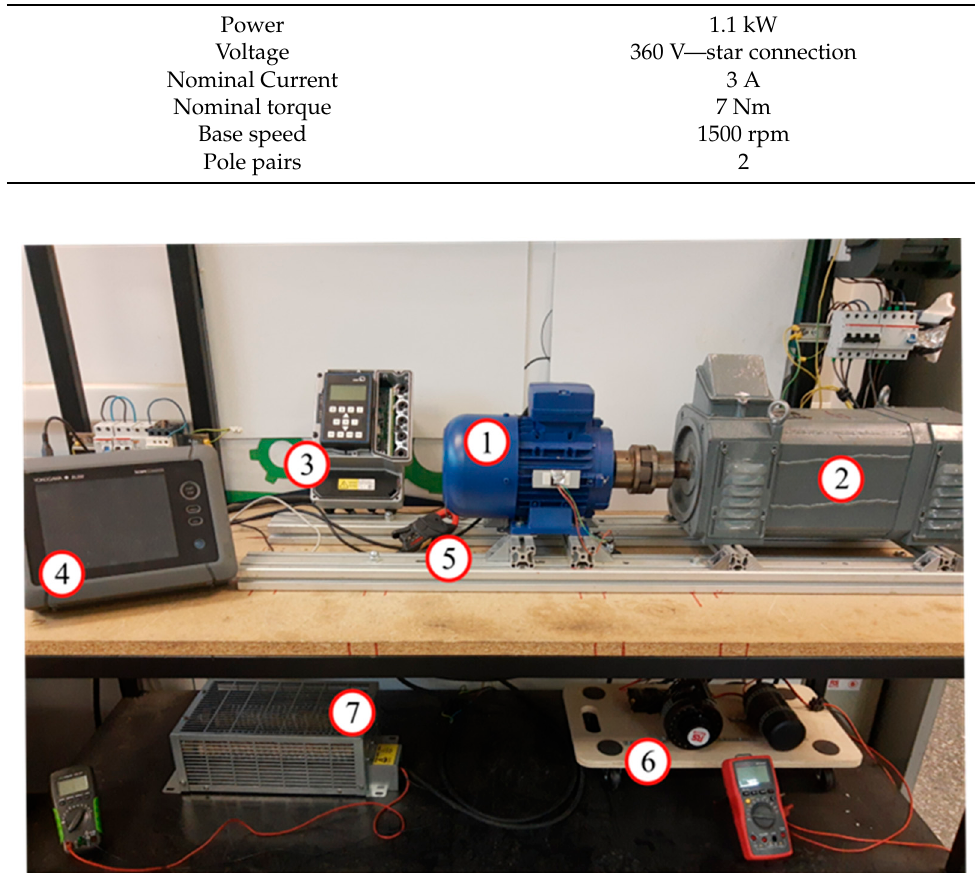
Table 8. Main characteristics of the SynRM.